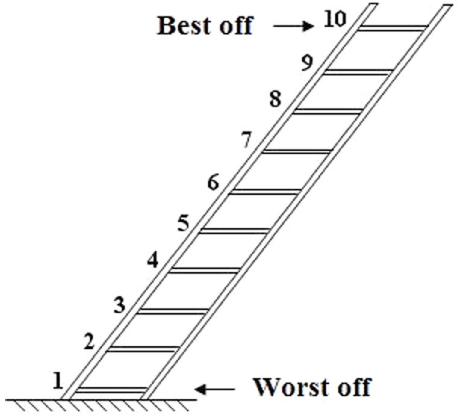
Figure 1. MacArthur scale of subjective social status. It is used to assess patient and doctor subjective evaluation of patient social